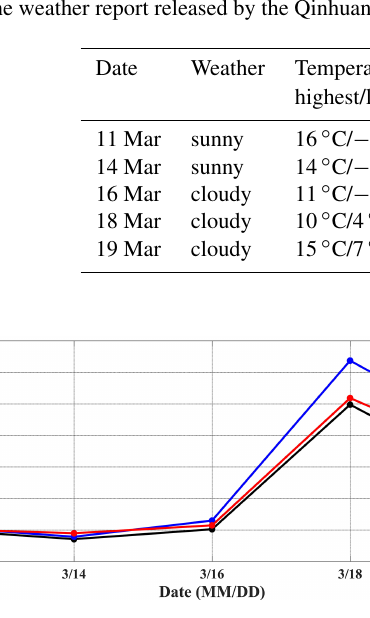
Figure 16. Aerosol optical depth results on different dates. The blue scatter points are measured by the sun photometer of Funing ground station. The black scatter points are the measurement results of the airborne lidar 532nm channel. The red scatter points are the mea- surement results of Moderate Resolution Imaging Spectroradiome- ter